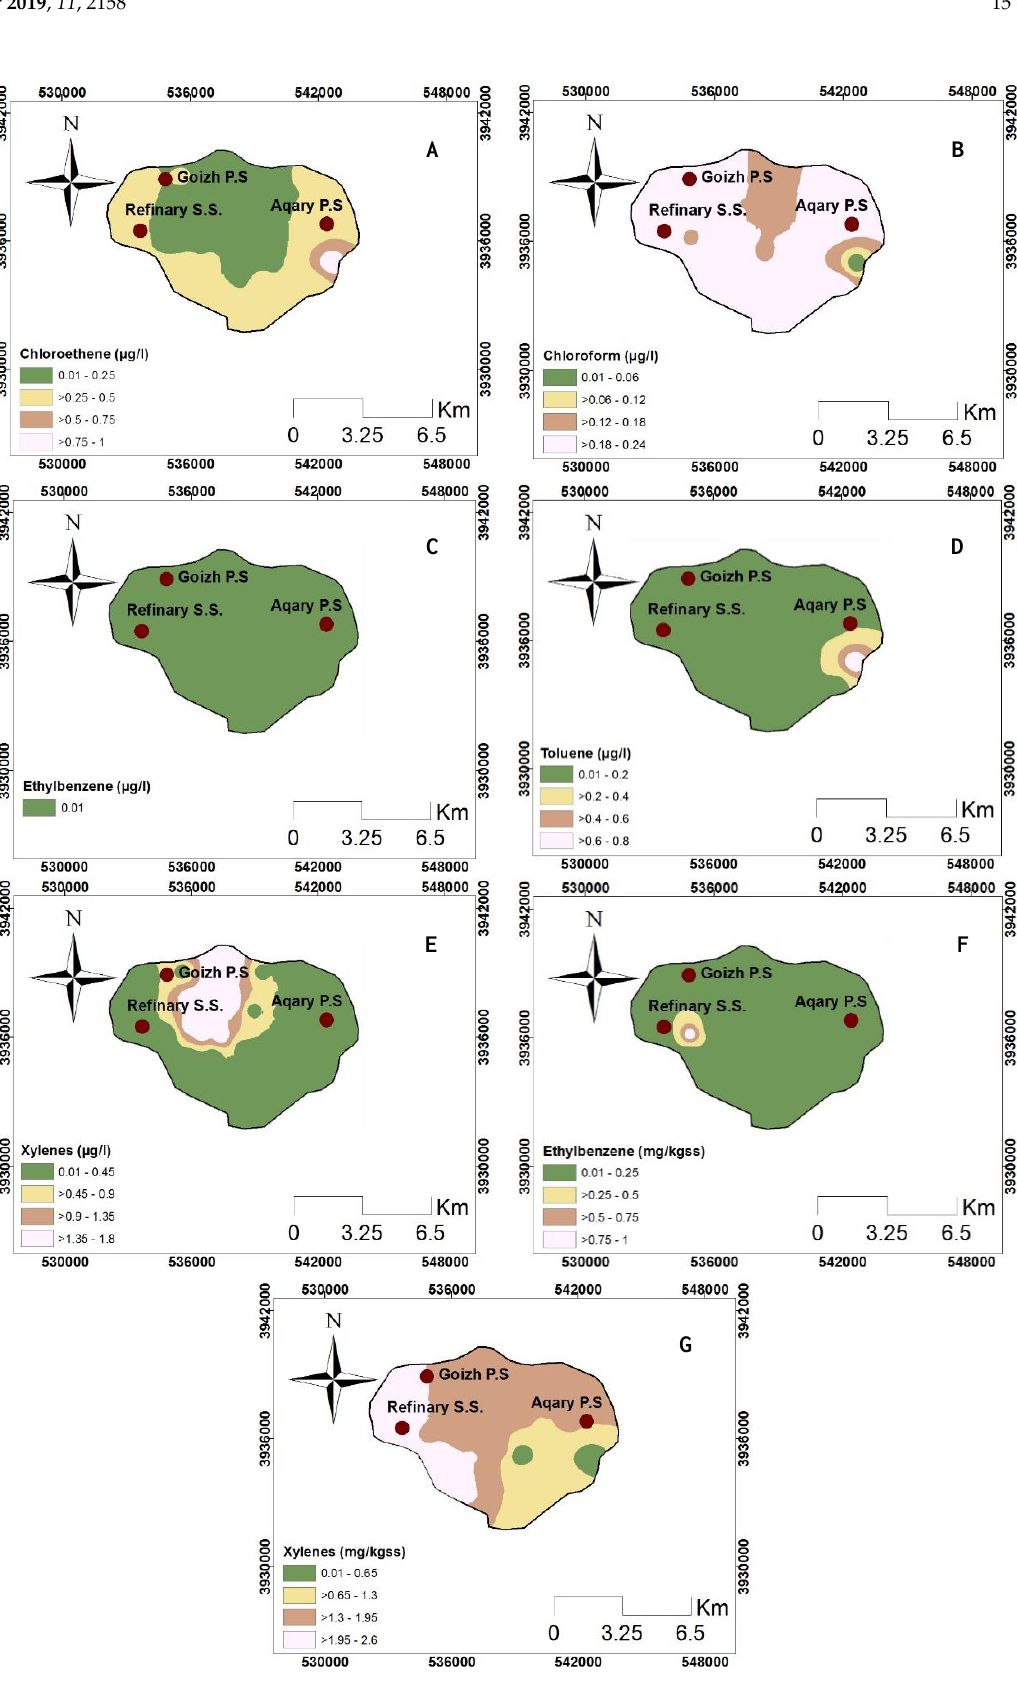
Figure 8. Spatial distribution of the selected LNAPL components over the studied area: ( A – E ) in water samples, and ( F , G ) in soil samples.